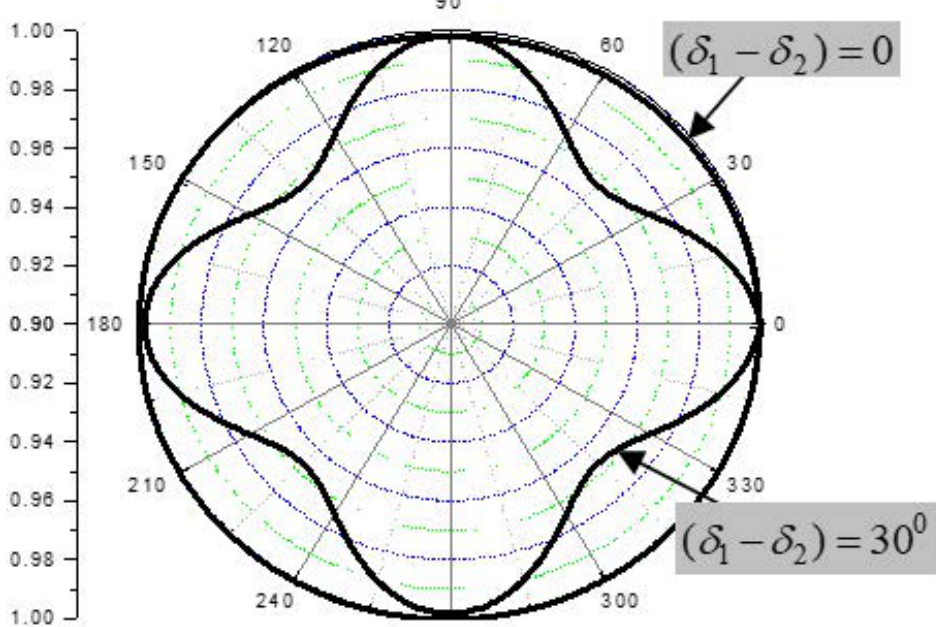
Figure 21. Amplitude response of birefringence to ≈ 60 µ m offset in 0–90 ◦ CFRP